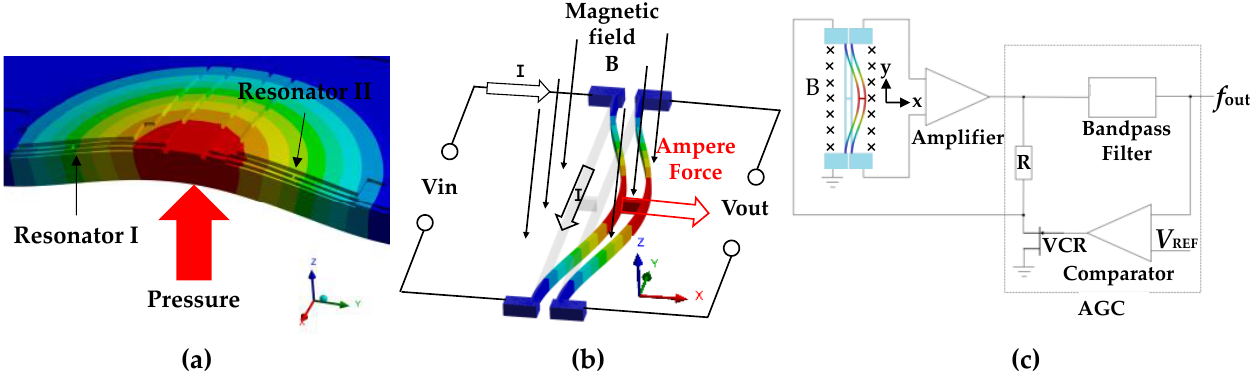
Figure 2. ( a ) The stress distribution on sensing elements under pressure; ( b ) the working principle of the resonator; ( c ) the working principle of the presented microsensor.